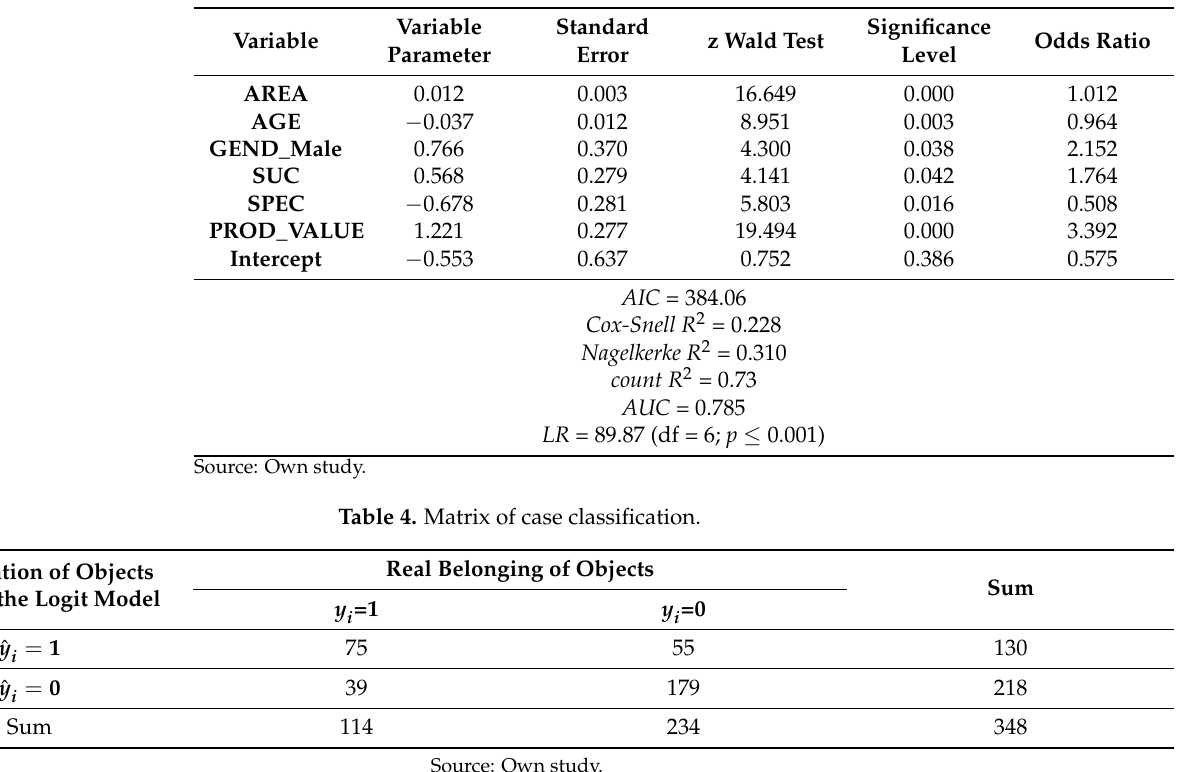
Table 3. Results of estimation of model parameters—final model.